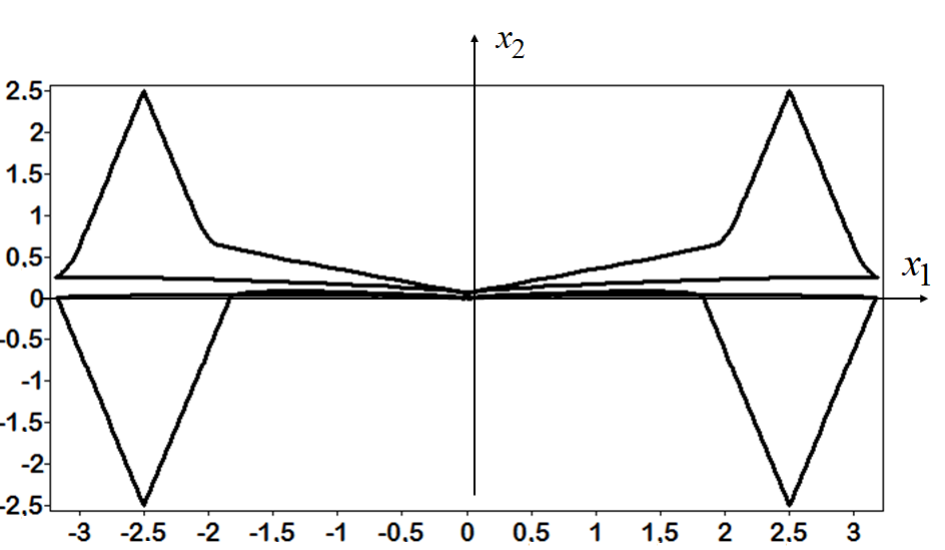
Figure 6. Trajectories of the robot with control law trained by